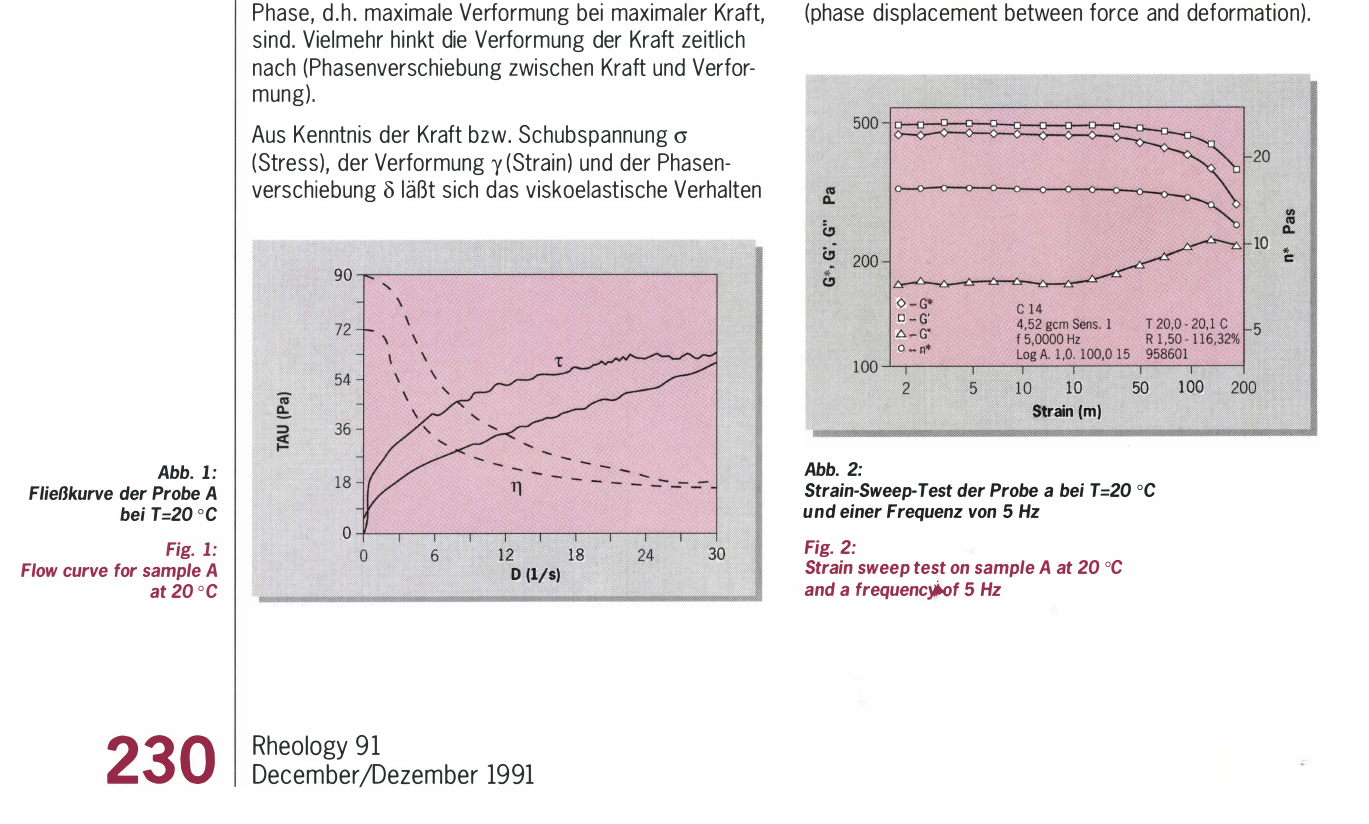
Fig. 2: Strain sweep test on sample A at 20 oc and a frequenc }ta f 5